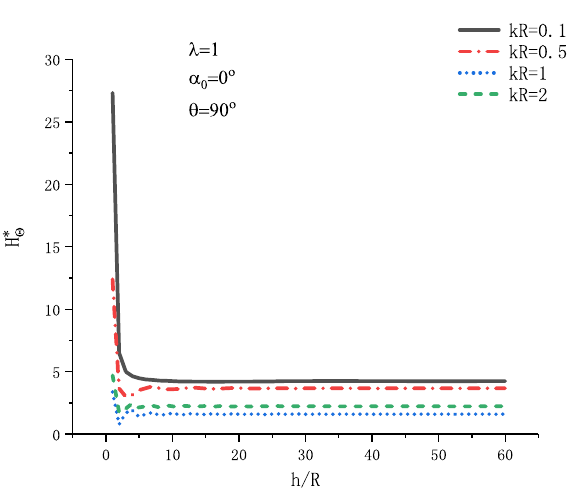
Figure 21. Variation of H